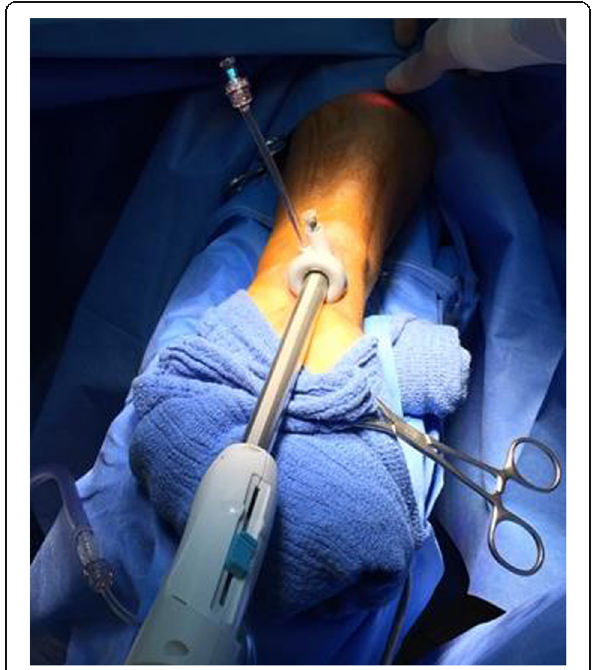
Fig. 2 The VasoView cannula inserted through the forearm